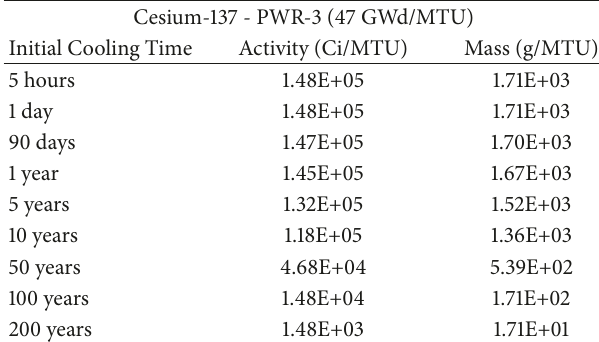
Table 1: Activity and mass of Cesium-137 in the spent fuel per MTU (adapted from [10]).